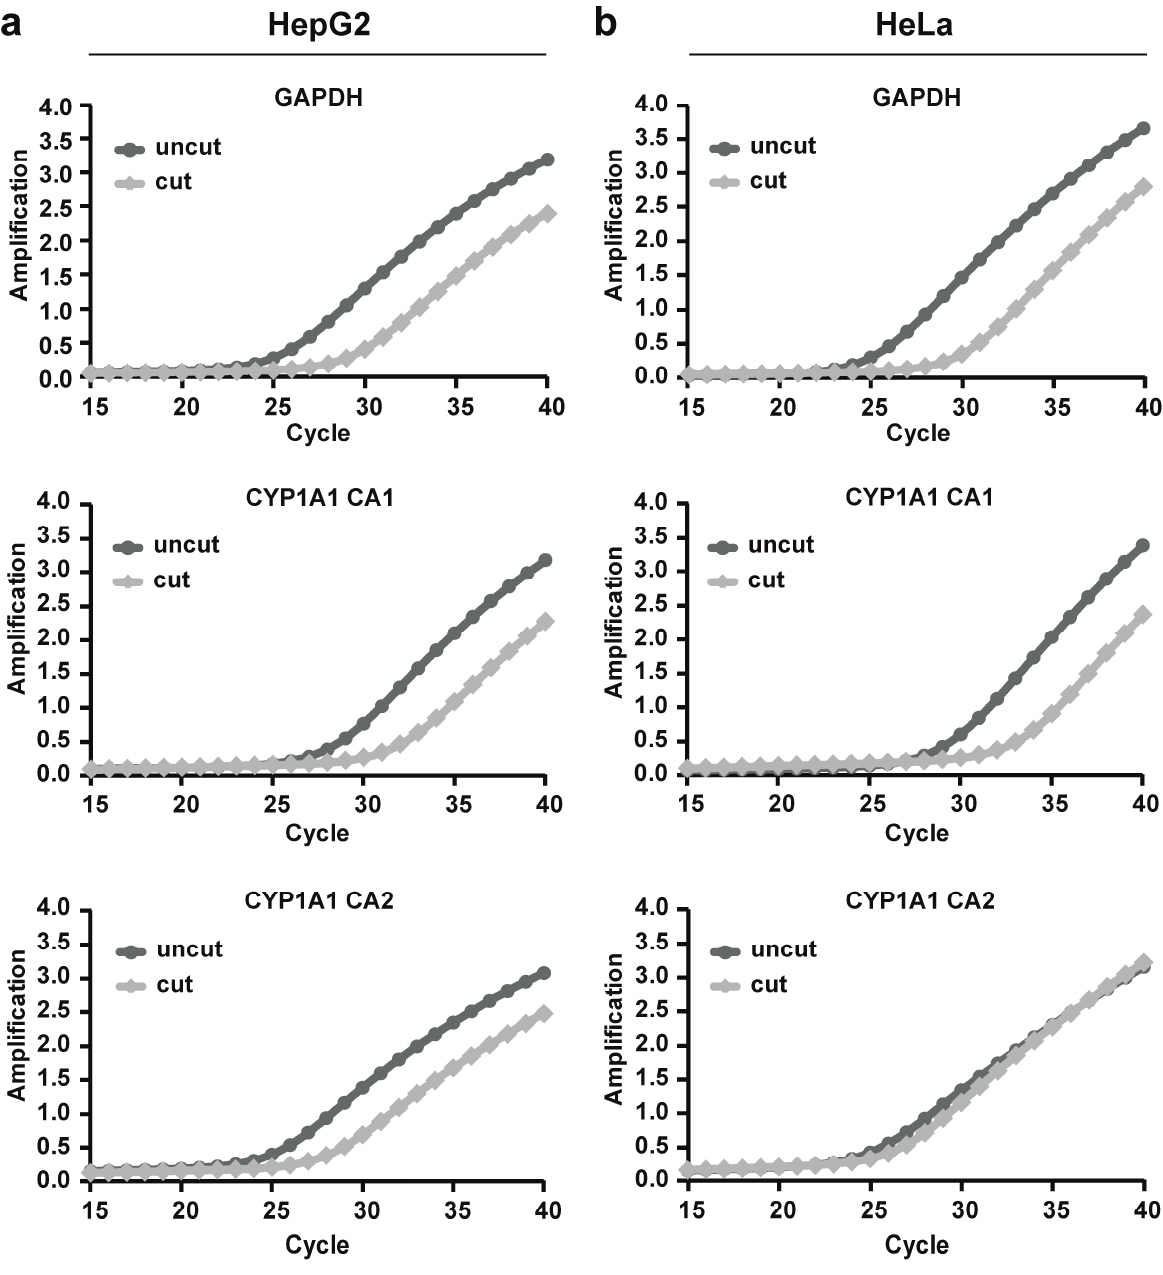
Figure 2. Chromatin accessibility along the CYP1A1 promoter in HepG2 and HeLa cells. Nuclei of HepG2 cells ( a ) and HeLa cells ( b ) were isolated and digested with DNase. qRT-PCR was used to amplify two different regions of the CYP1A1 promoter that were also analyzed by bisulfite sequencing. Amplification of GAPDH was used as a positive control for accessible chromatin. Results are depicted as magnitude of the signal ( ∆ R cycle